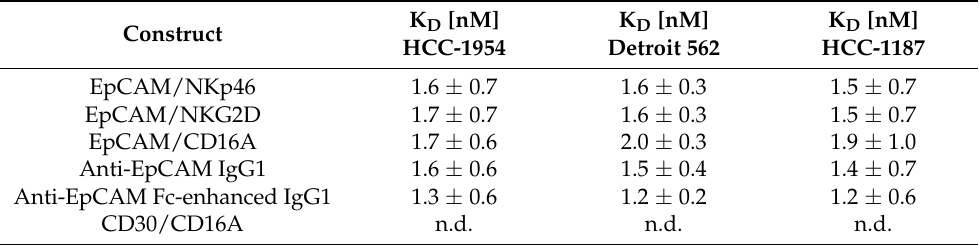
Figure 4. Concentration-dependent binding of anti-EpCAM ICE ® constructs and anti-EpCAM IgG1 antibodies to EpCAM + tumor cells. EpCAM + HCC-1187 tumor cells were incubated with serial dilutions of EpCAM/NKp46, EpCAM/NKG2D, EpCAM/CD16A, anti-EpCAM IgG1, anti-EpCAM Fc-enhanced IgG1, and CD30/CD16A ICE ® as a control at 37 ◦ C. The cell-surface bound antibody constructs were detected with FITC-conjugated goat anti-human IgG Fc and flow cytometric analysis. Data for one representative experiment out of three experiments are presented. FITC, fluorescein isothiocyanate. Table 5. Apparent affinities of bispecific ICE ® constructs and control antibodies to EpCAM + tumor cell lines.